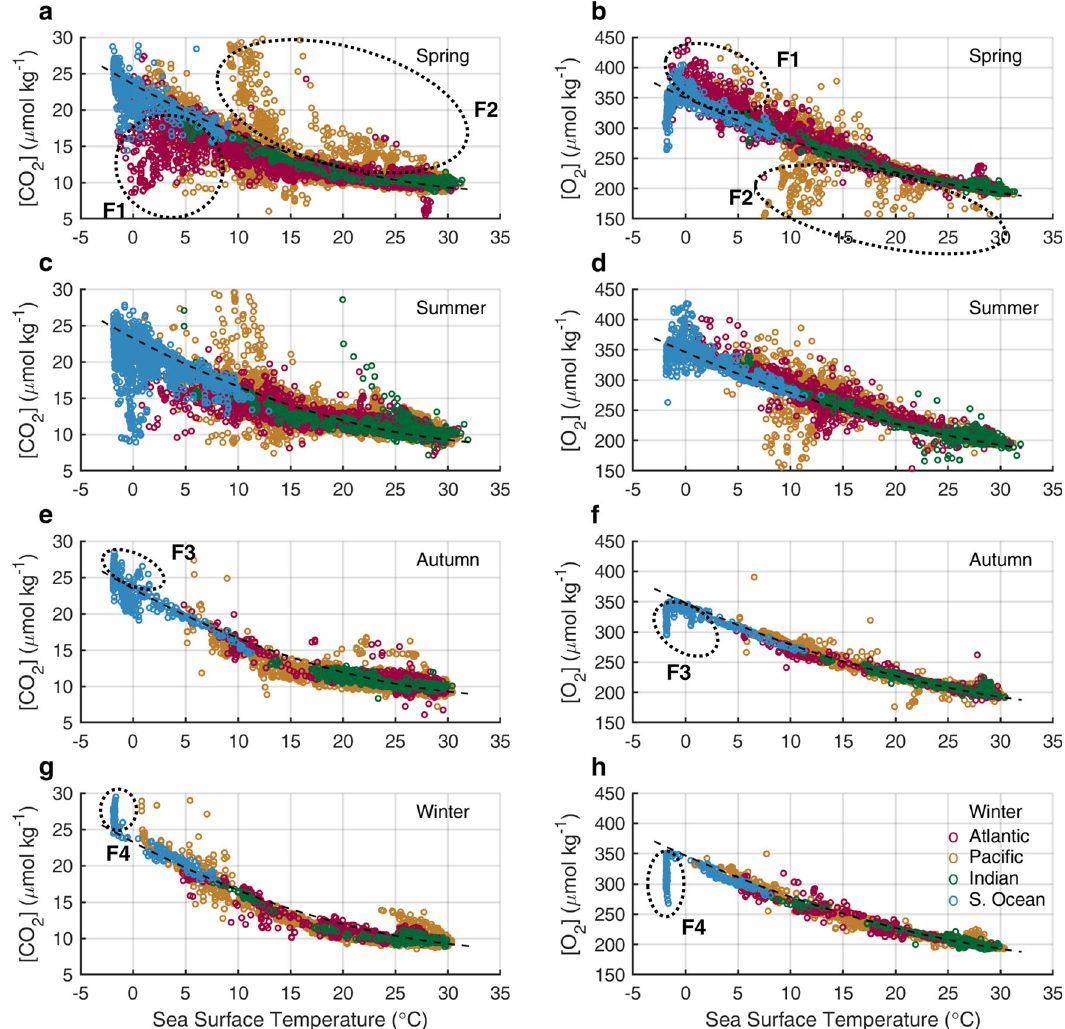
Fig. 1 Sea surface dissolved CO 2 and O 2 against sea surface temperature in the global dataset GLODAPv2. Each row is a different season; [CO 2 ] data are shown in ( a , c , e , g ) and [O 2 ] data in ( b , d , f , h ). The black dashed curves indicate the saturation values of [CO 2 ] or [O 2 ] (i.e., concentrations that would be in equilibrium with the atmosphere). The saturation curves for [CO 2 ] were calculated with respect to the atmospheric p CO 2 of 380 µ atm in year 2005 and fi tted. For this fi gure only, [CO 2 ] values measured in other years were adjusted to year 2005 following Wu et al. 67 to be consistent with the saturation values calculated. Colors indicate different ocean basins: Atlantic (magenta), Paci fi c (dark yellow), Indian (green) and Southern Ocean (blue). Dotted ovals with labels F1 – F4 highlight major features, discussed in the “ Results